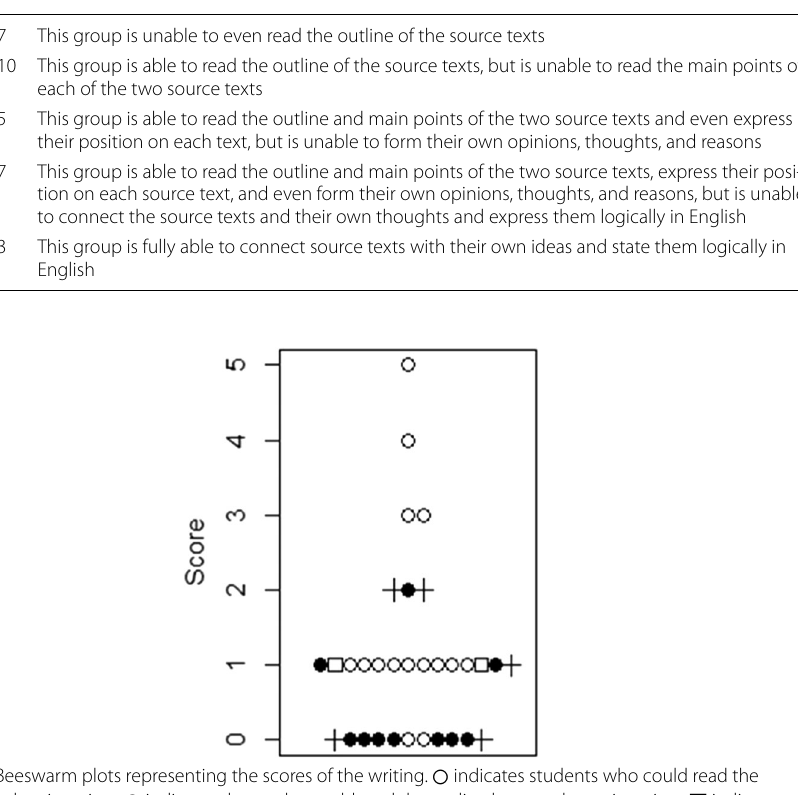
Table 6 Each group and the characteristics discovered Group n Characteristics